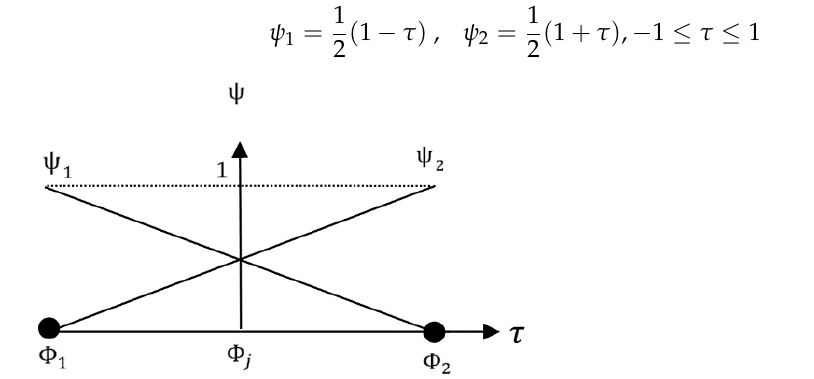
Figure A2. Local element interpolation functions.